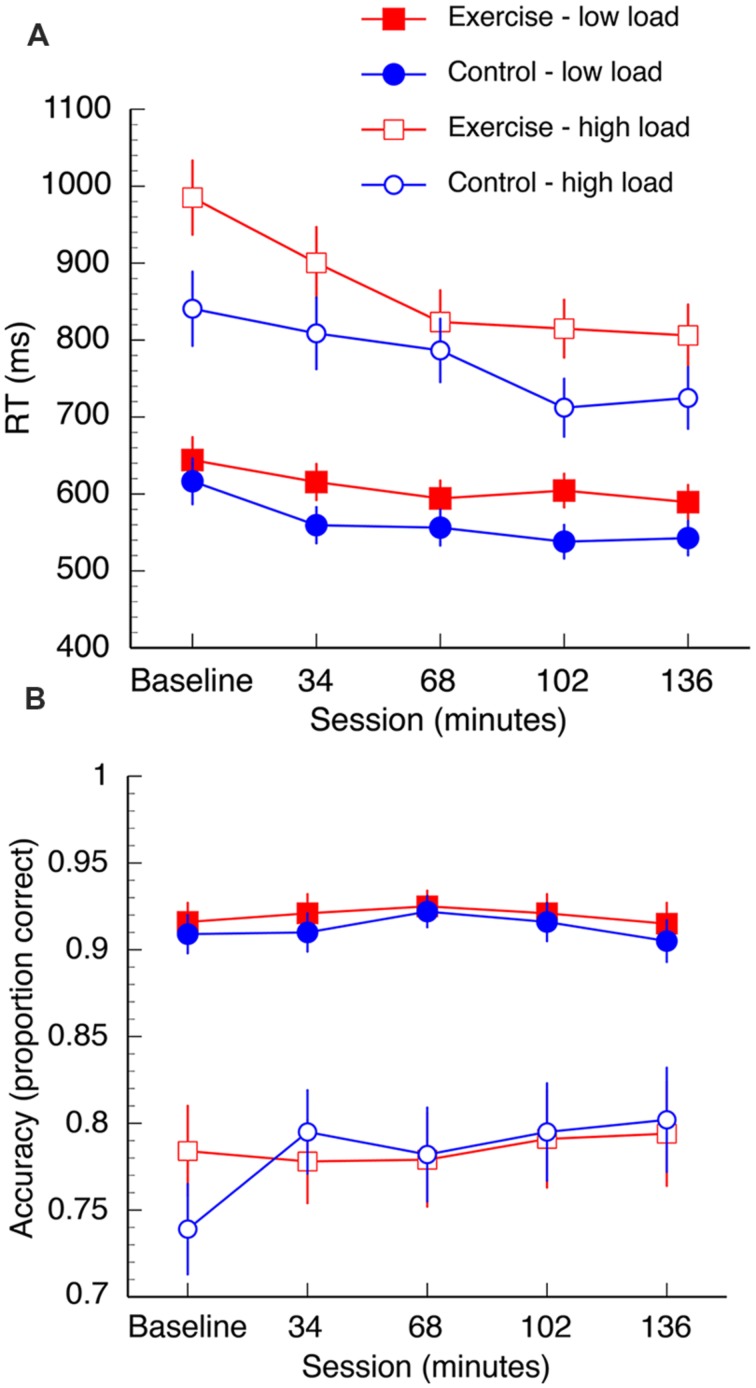
Mean reaction time (A) and accuracy data (B) for both groups. Data are collapsed over “distractibility” as this variable was not found to interact with any other variables. Error bars represent SEM.